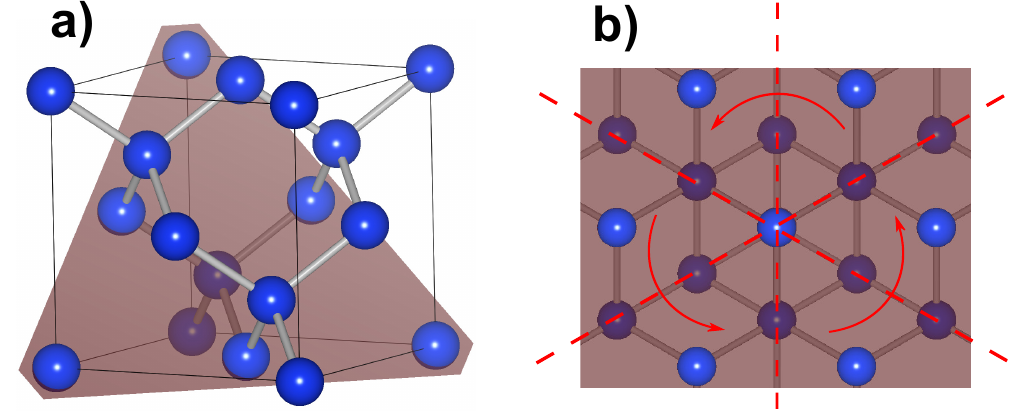
Figure 9. Crystal structure of silicon. ( a ) Unit cell with (111) oriented lattice plane (red); ( b ) Top view of the (111) oriented silicon surface. The symmetry of the surface belongs to group C distinguishable from the threefold rotational 3 ,v